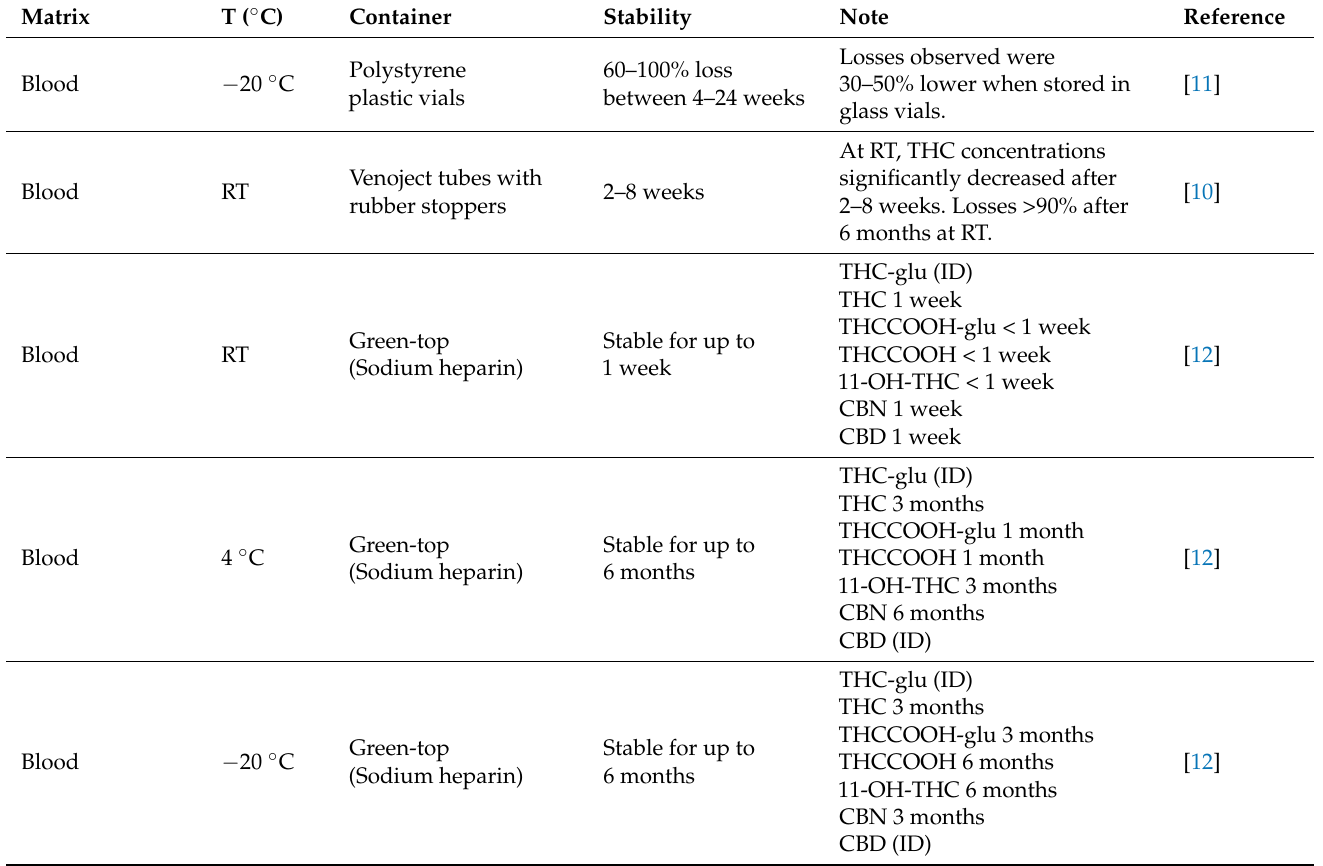
Table 1. Duration of storage stability for cannabinoids in blood based on temperature and collec- tion